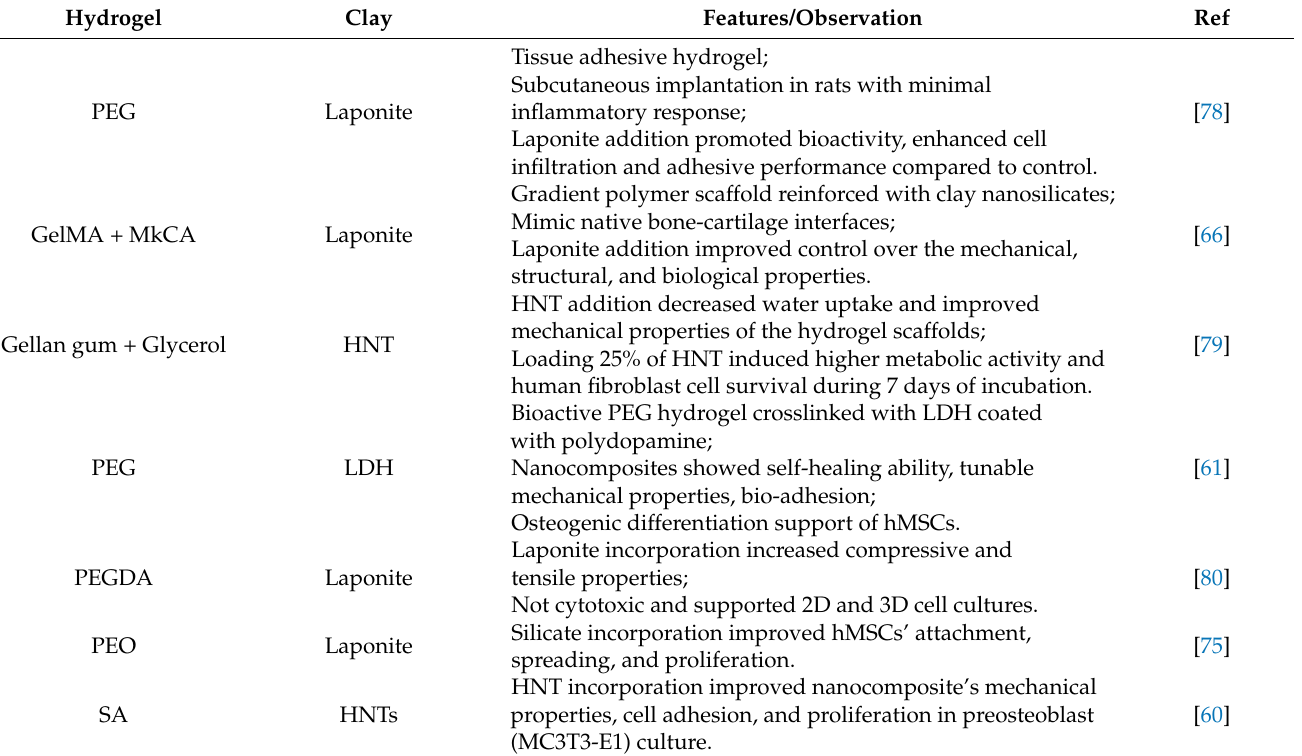
Table 1. Clay nanoparticles in hydrogel nanocomposites for soft tissue engineering applications.